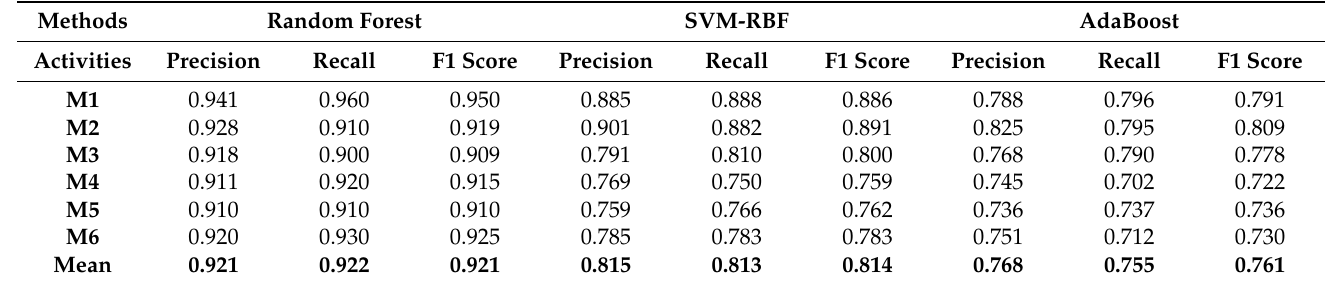
Table 4. Comparison of the evaluation metrics (precision, recall, and F1 score) of the HPAR model from the MOTIONSENSE